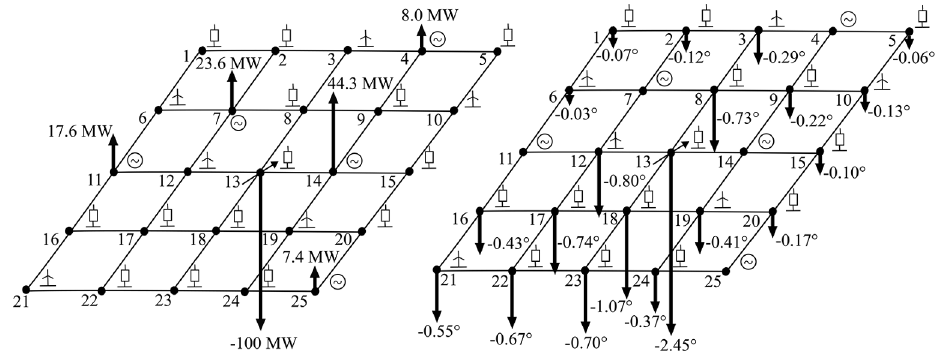
Fig. 13. – Left: increase in power consumption by load at node 13 and the resulting increases in the generation of every slack power plant. Right: angle changes in PV generators and PQ consumers during the increase in load power consumption at node